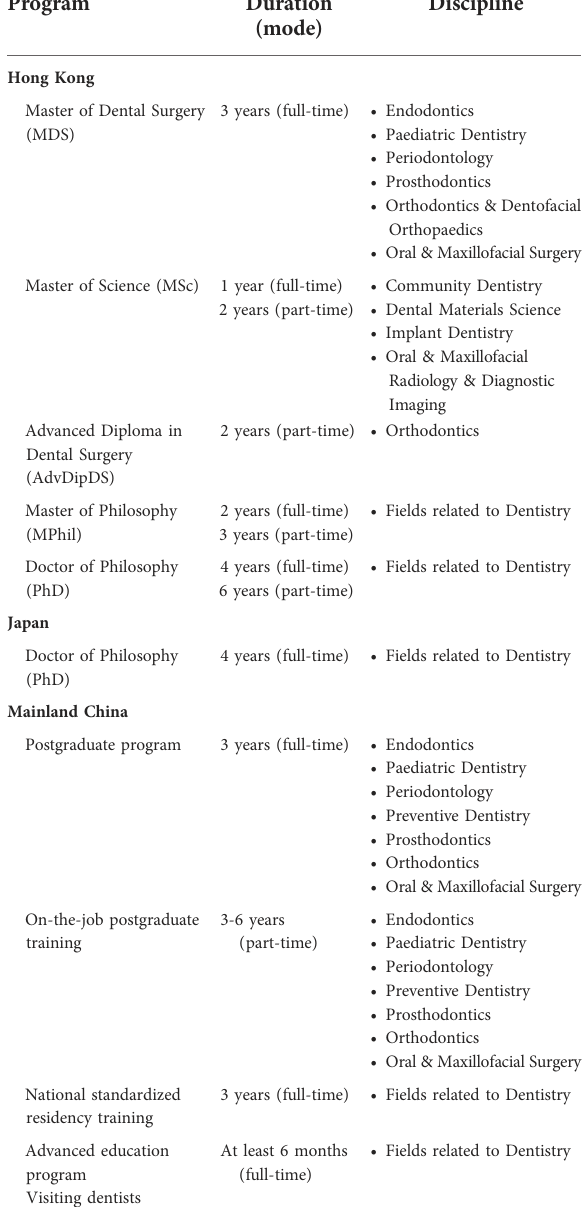
TABLE 2 Options for further study and training for dental